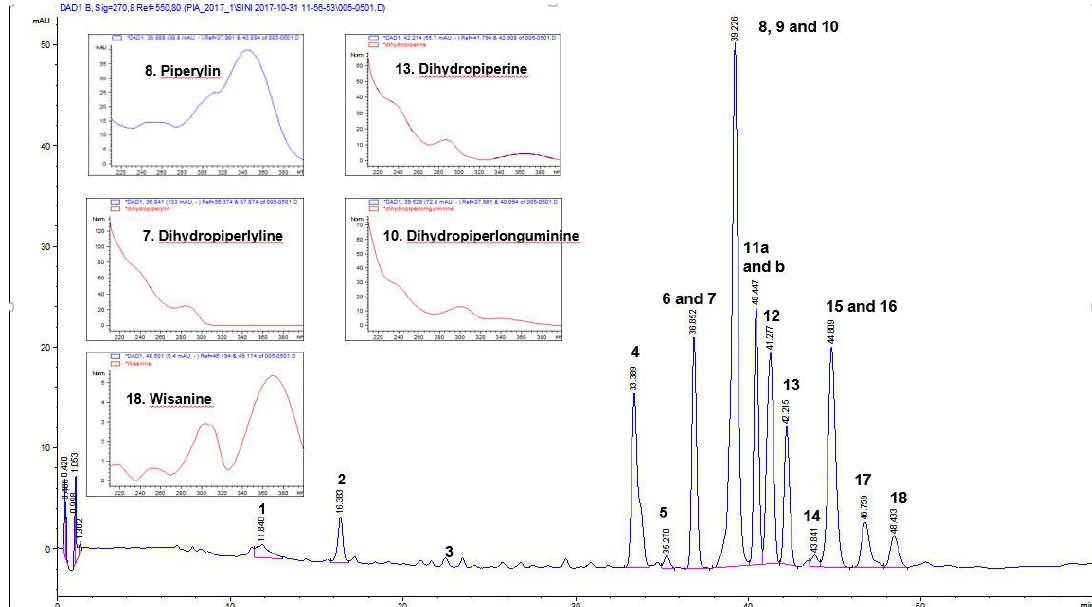
Figure 1. HPLC profile and identified piperamide alkaloids in an antibacterial hexane leaf extract of P. guineense at 270 nm. The bioactive compounds identified in this extract are also shown in Table 4. UVλ absorption maxima of some of the compounds are indicated.